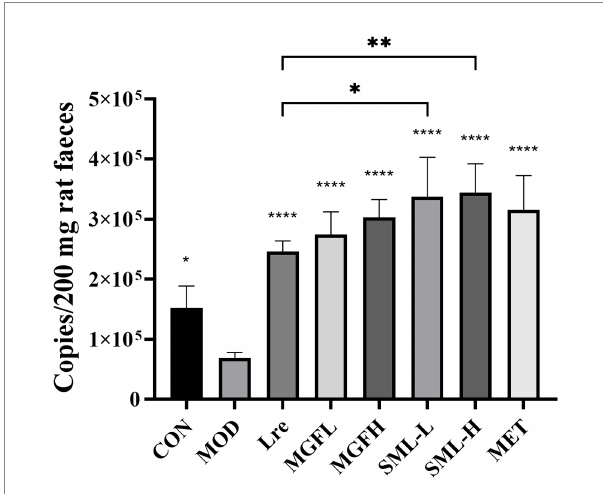
FIGURE 9 Absolute quantification results of Lactobacillus reuteri. * p < 0.05, ** p < 0.01, **** p < 0.0001 compared with the MOD, and the SML and its components were